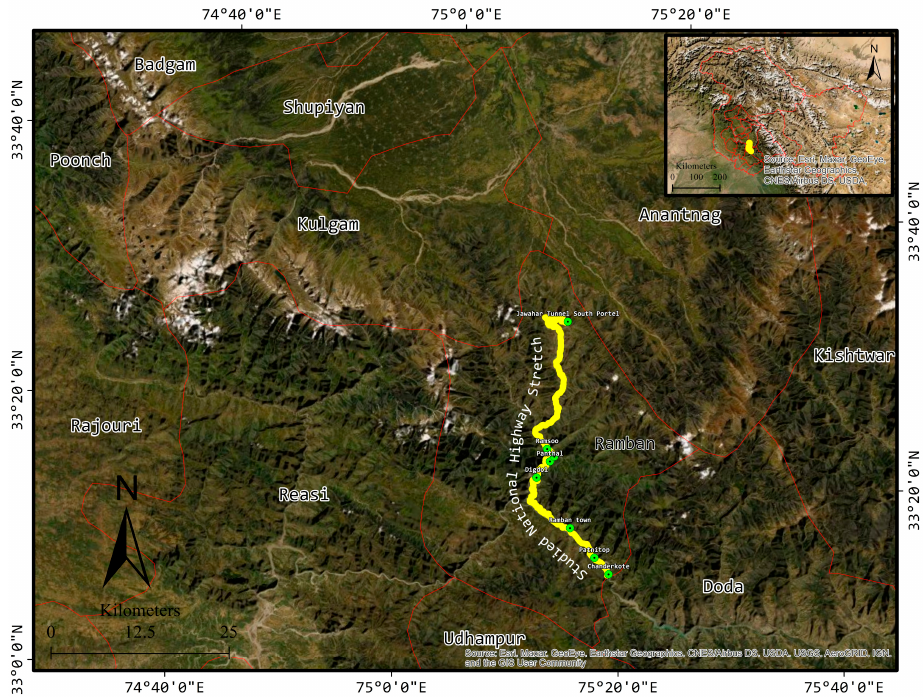
Figure 1. Location map of the National Highway NH-44 stretch studied in this paper. The upper right inset is its location with reference to the UT of Jammu and Kashmir, India. The red outlines are the districts of the UT of J and K. The green dots on the National Highway are the prominent landmarks as well as the sampling points. The map coordinates are in the UTM 43 (North) World Geodetic System (WGS-1984) reference system.